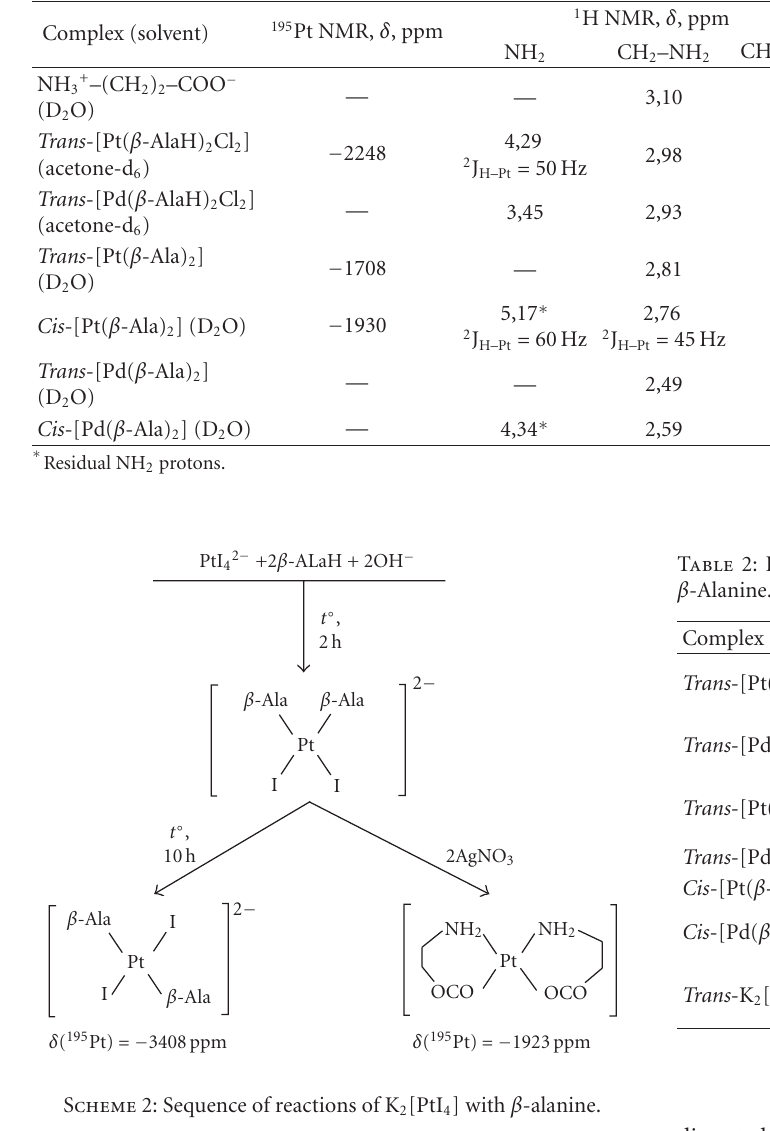
Table 1: NMR spectral data for β -AlaH and the Pt(II) and Pd(II) complexes with β -AlaH.